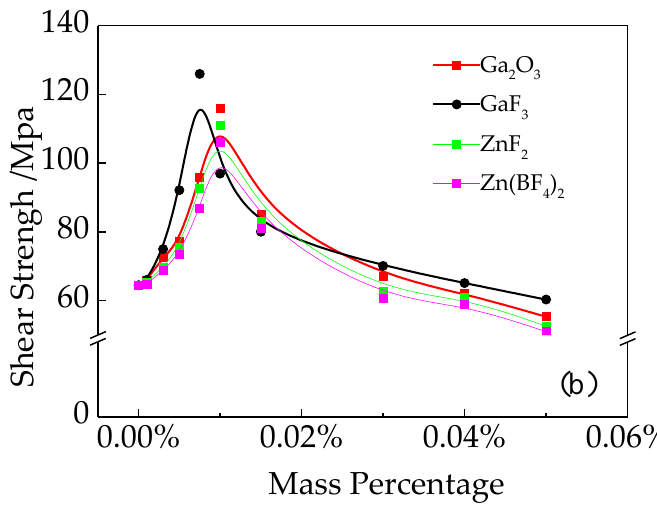
Figure 5. Influence of contents of GaF 3 , ZnF 2 , Zn(BF 4 ) 2 and Ga 2 O 3 on shear strength of brazed joints.